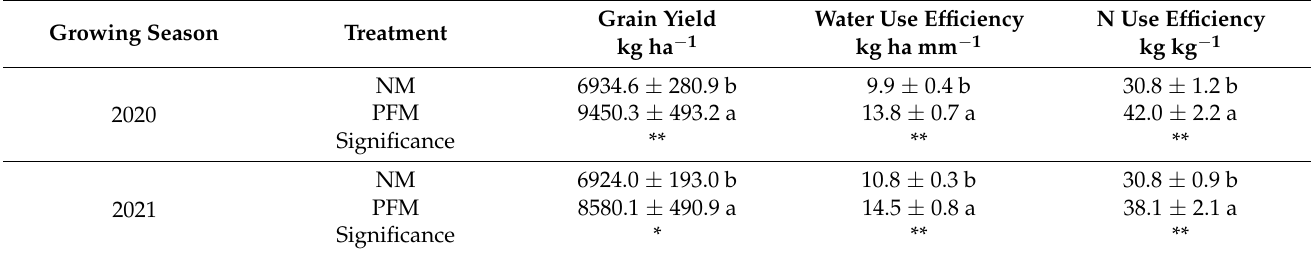
Table 2. Effects of plastic film mulching and no-mulching treatments on grain yield, water use efficiency, and nitrogen use efficiency of spring maize under rainfed semi-arid ecosystem of northeastern